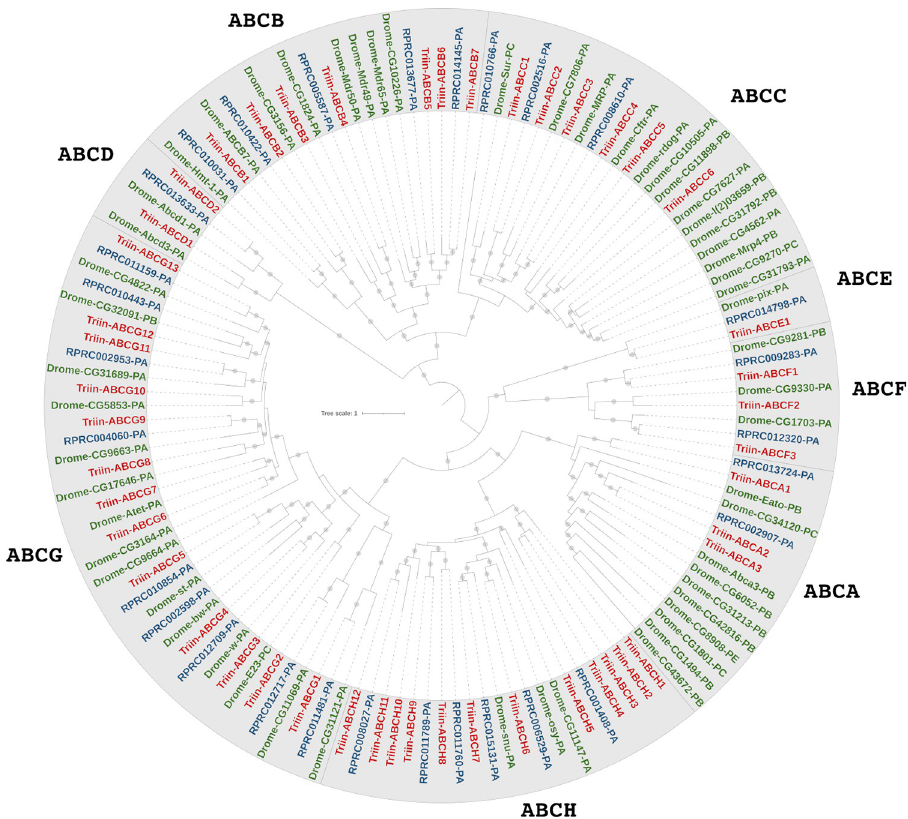
Fig 6. Phylogenetic tree of the ABC transporter superfamily from T . infestans , R . prolixus and D . melanogaster . The maximum-likelihood tree was constructed using IQ-Tree and protein sequences obtained from T . infestans transcriptome (Triin-, red, available in Table G in S2 File) and from R . prolixus (RPRC-, blue, VectorBase ID is shown) and D . melanogaster (Drome-, green, FlyBase gene name and isoform are shown) genomes. Only those sequences complete enough for phylogenetic characterization were included in the tree (remaining sequences were given a preliminary classification shown in brackets in Table G in S2 File). Triatoma infestans sequences were numbered according to their position in the tree. Branches with SH-aLRT support values > 80 are marked with a grey dot. The tree was rooted at midpoint.